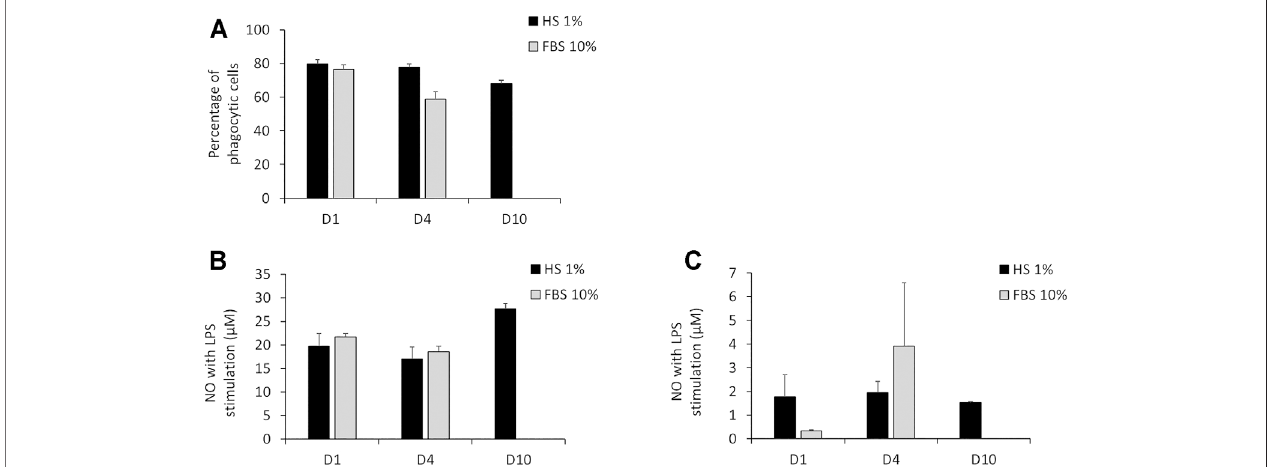
FIGURE4| Mainfunctionalitiesmeasurementofmacrophages. (A) Percentageofphagocyticcellsmeasured via engulfmentofY/G fl uorescentlatexbeads. (B) NO secretion with LPS stimulation for 12 h. (C) NO secretion without LPS stimulation. 24 h (D1), 4 days (D4) and 10 days (D10) of culture in DMEM +1% horse serum (1% HS). Black bars; culture medium supplemented with DMEM +1% Horse Serum (1% HS). Grey bars; culture medium supplemented with DMEM +10% Fetal Bovine Serum (FBS) (N (cid:1) 3). No measurements were made for cells maintained in DMEM+10% FBS because of the important cell detachment occurring, as mentioned in the previous section.